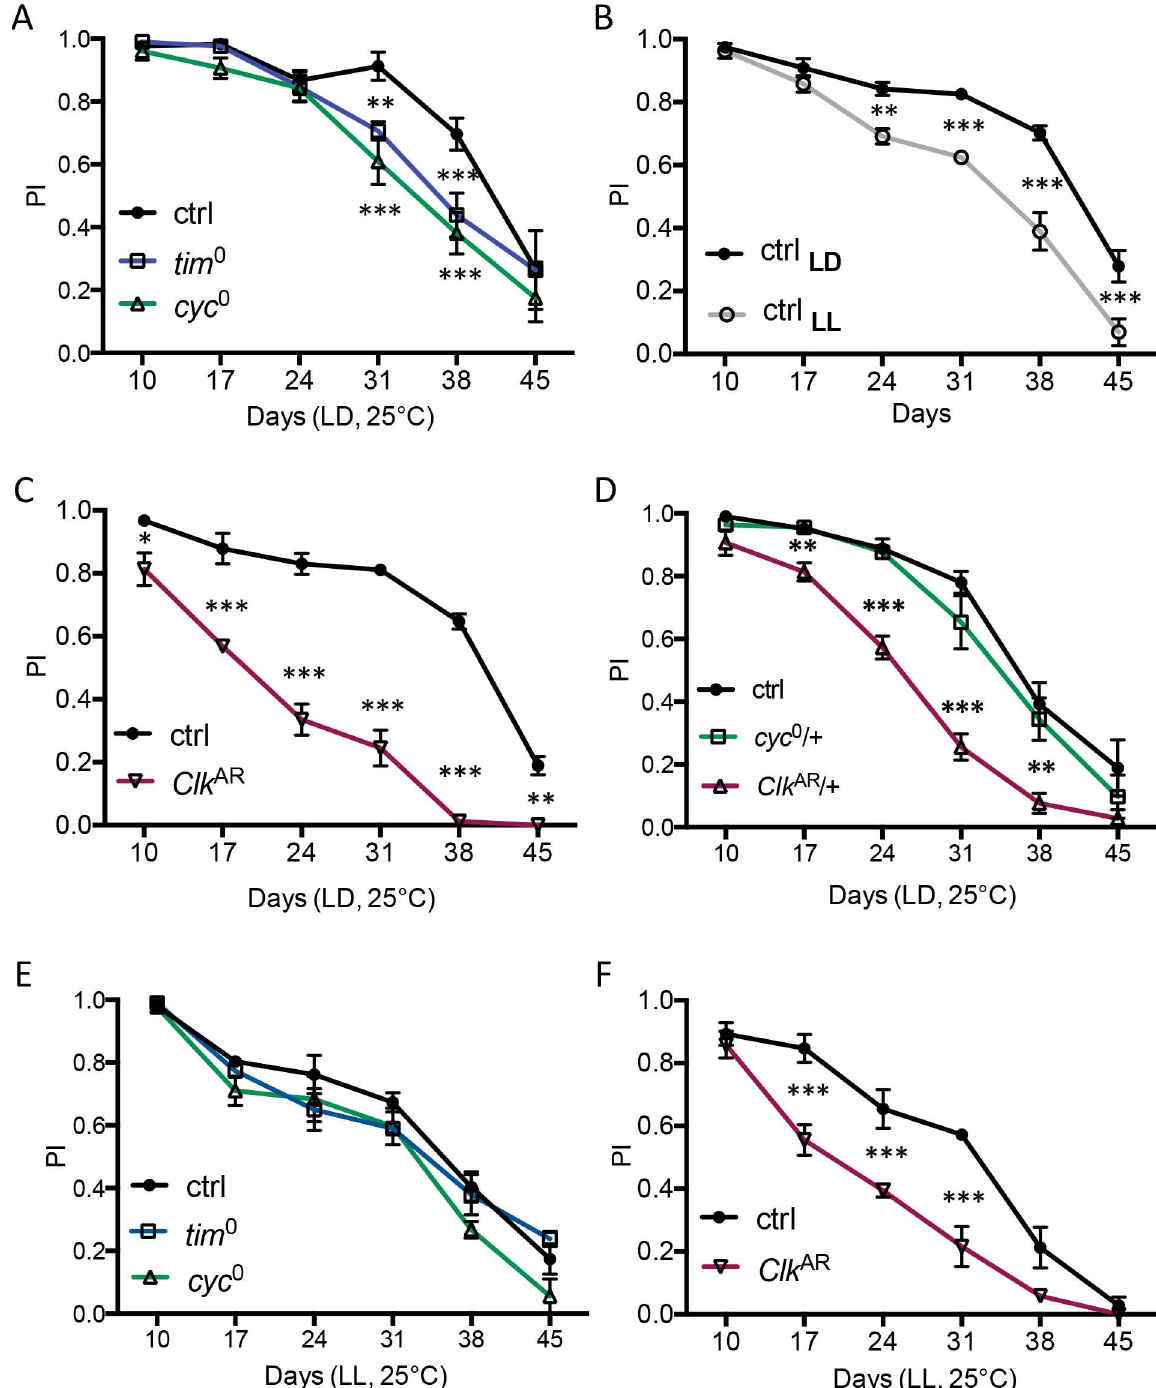
Fig 1. Age-related locomotor impairment (ARLI) in cyc 0 , tim 0 and Clk AR arrhythmic mutants. (A) ARLI of cyc 0 and tim 0 mutants is accelerated relative to wild-typeflies (ctrl) housedin LD. (B) ARLI of wild-typeCanton-S flies (ctrl) is accelerated under constant light (LL) that stops the clock. (C) The effect of Clk AR mutation on ARLI is stronger and occurs earlier than the effect of cyc 0 , tim 0 or LL. (D) Clk AR /+, but not cyc 0 /+, heterozygote mutants also exhibit an acceleratedlocomotor declineas comparedto controls. (E) No effect on ARLI is observed for cyc 0 and tim 0 mutants in constant light (LL). (F) In contrast, Clk AR mutants exhibitan acceleratedARLI under constant light when compared to wild-type flies (ctrl) kept in LL as well. Graphs displaythe means ± SEM from 2–3 independent